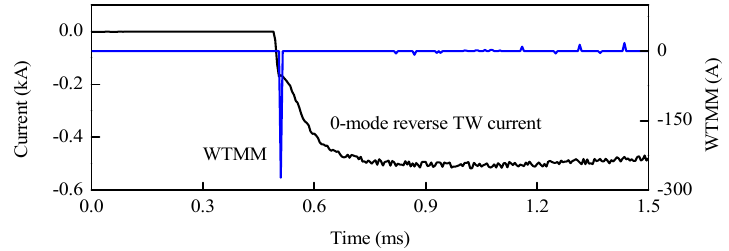
Figure 19. Faulty line selection under noise disturbance.